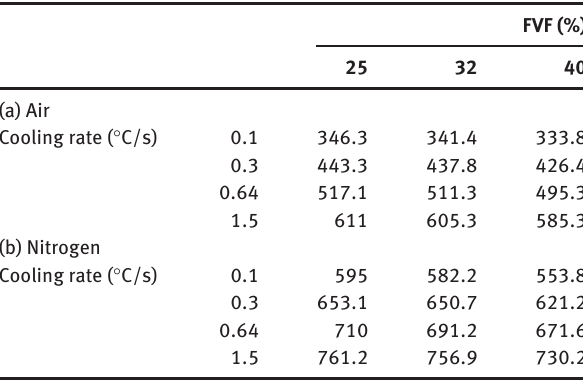
Table 3: Equivalent SFT ( ° C) for elastic-plastic models in (a) air and (b) nitrogen